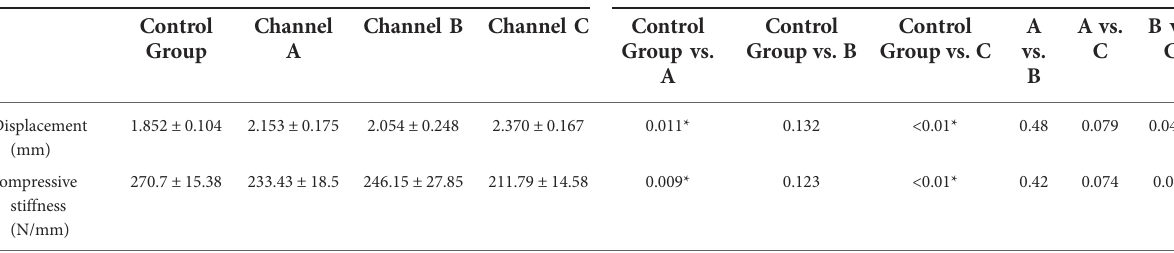
TABLE 3 Vertical displacement and compressive stiffness of pelvic specimens under 500 N